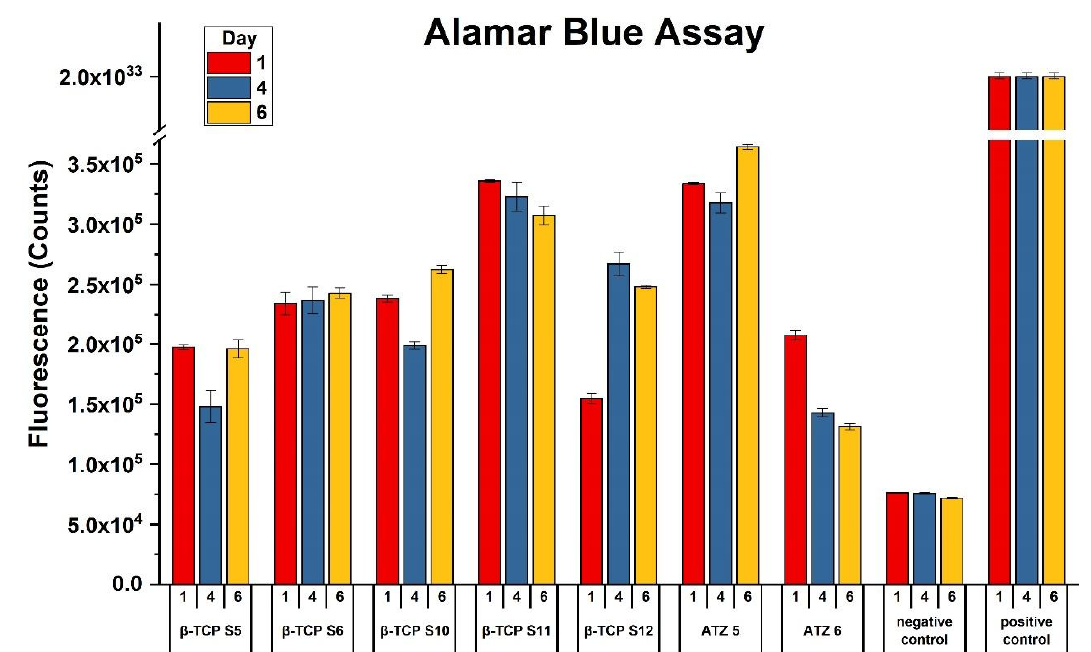
Figure 11. Bar graphs displaying the results of the Alamar Blue Assay on day 1 (red), 4 (blue), and 6 (yellow). The bars display the average data ± SD on three different days of analysis for all samples and negative control. Positive control values were the same for day 1, day 4, and day 6; 2.00 × 10 33 (average) 5.93173 × 10 17 (SD).